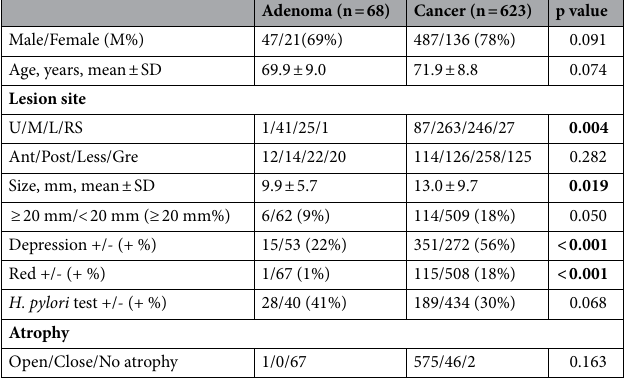
Table 1. Pre-matching patient characteristics. Significant values are in bold. U upper, M middle, L lower, RS remnant stomach. Ant Anterior wall, Post posterior wall, Less lesser curvature, Gre greater